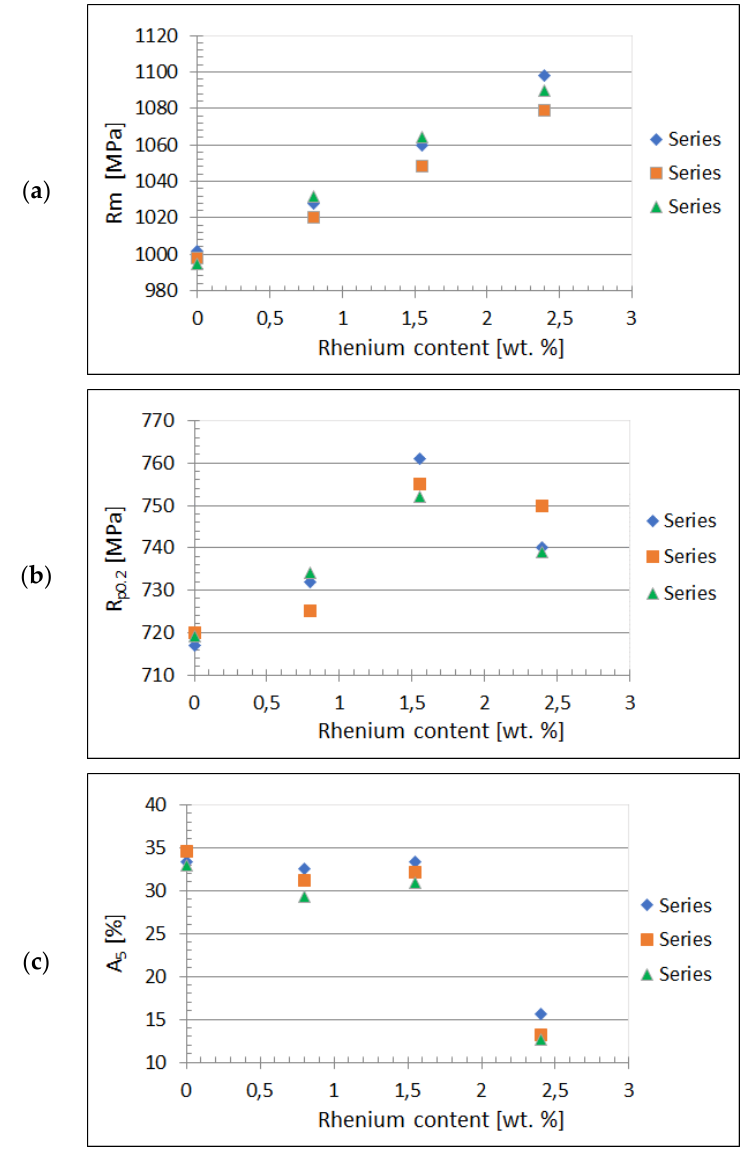
Figure 3. The results of tensile tests as a function of sintering cycles: ( a ) tensile strength, ( b ) yield strength, and ( c ) elongation.